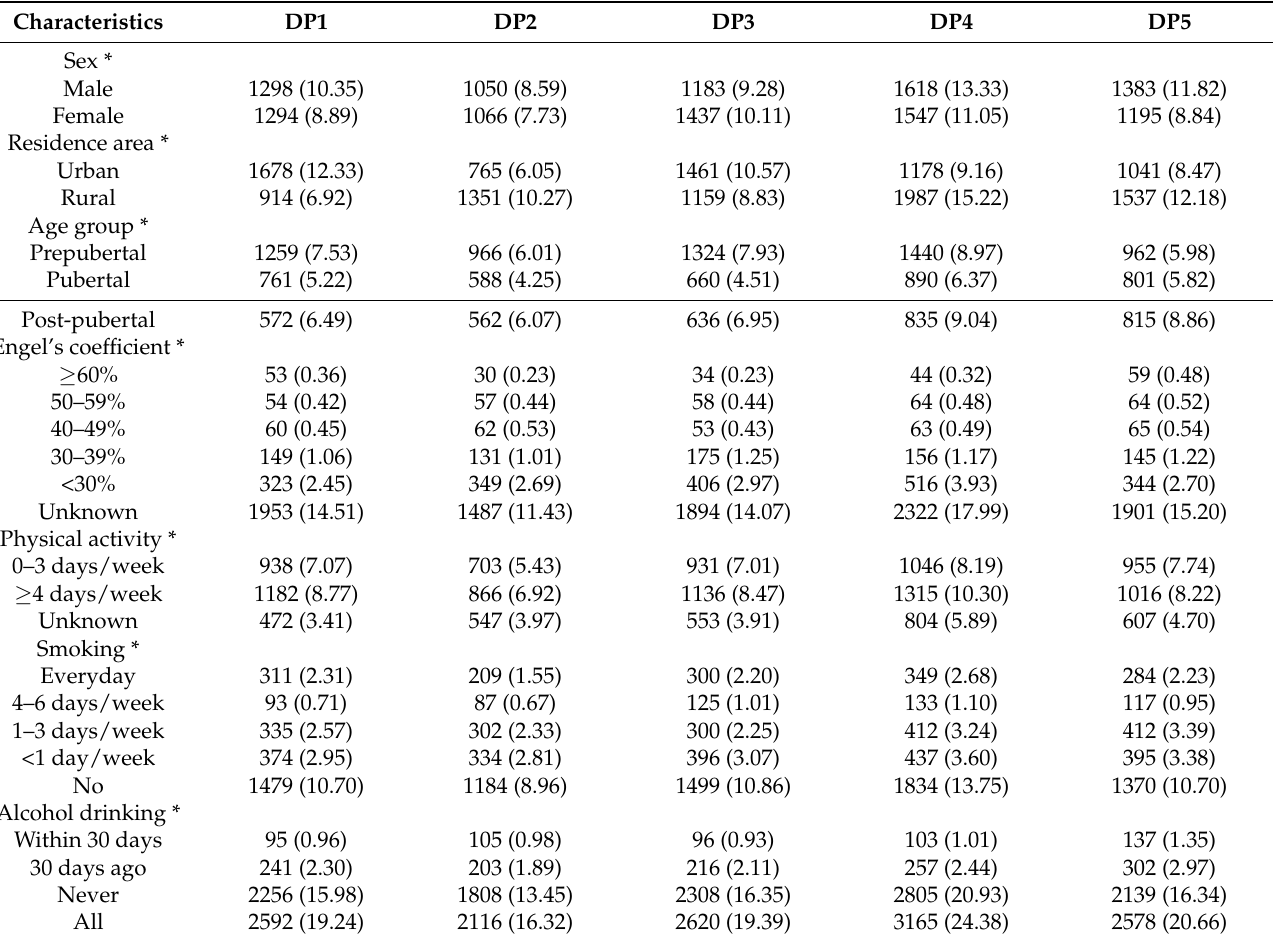
Table 2. Weighted percentages [ n (%)] of five DPs in children and adolescents aged 7–17 in 2016–2017.